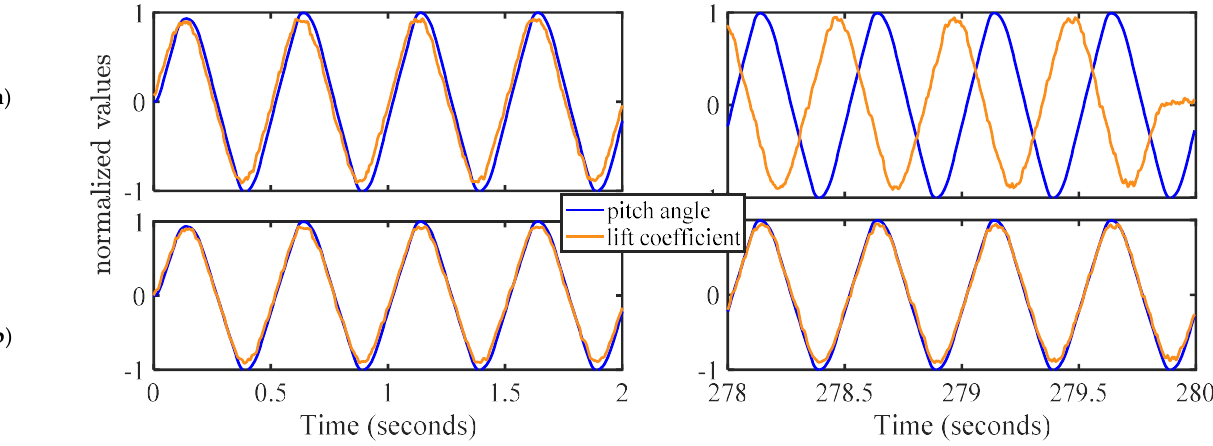
Figure 6. Illustration of the sampling frequency correction: ( a ) before correction, ( b ) after